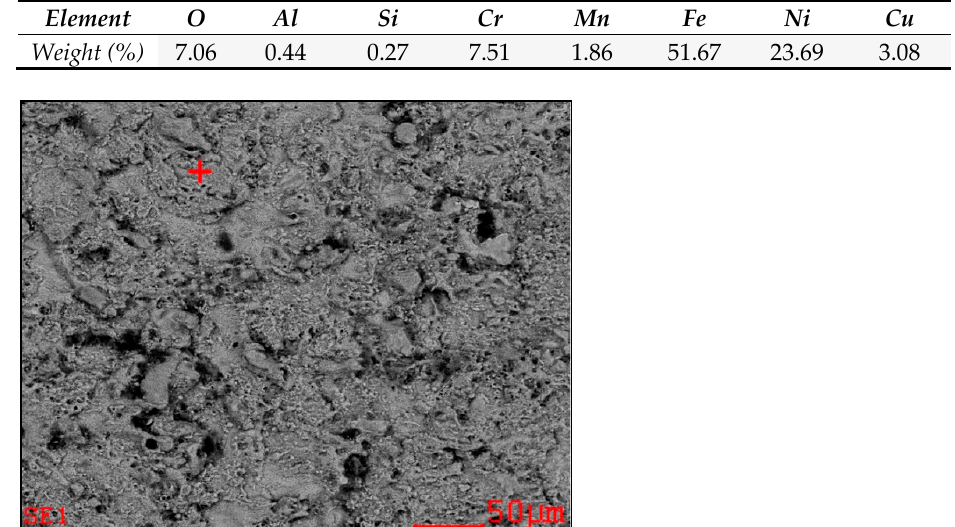
Figure 6. Gravimetric corrosion curves for molten salts tested during 500 h of immersion.